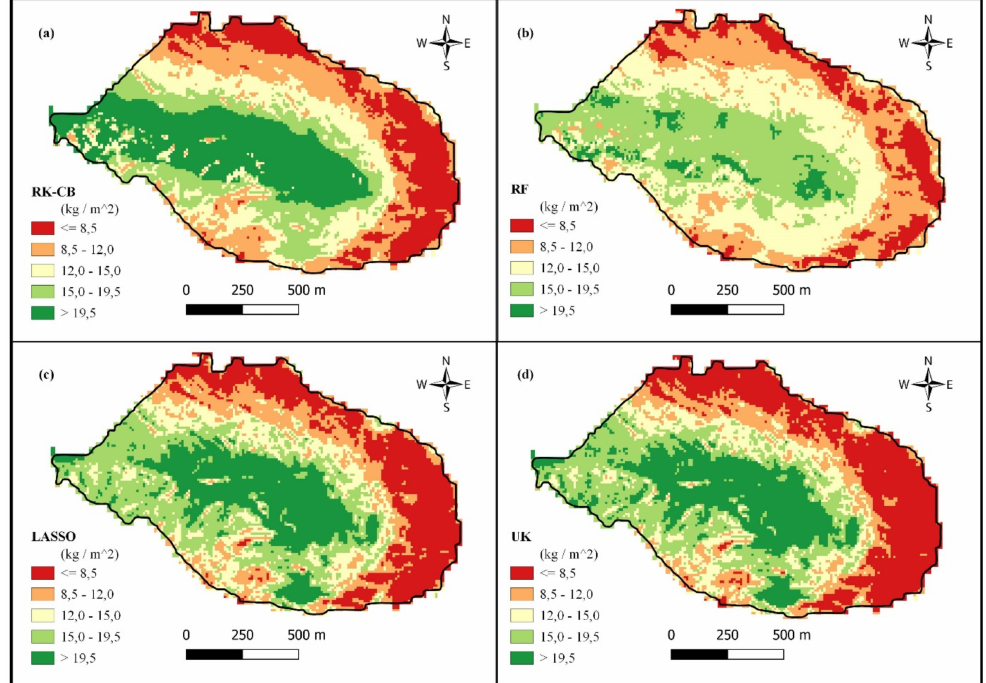
Figure 6. A comparison between the M2 catchment’s ( a ) RK-CB, ( b ) RF, ( c ) LASSO, and ( d ) UK, in order of their performance in regard to error